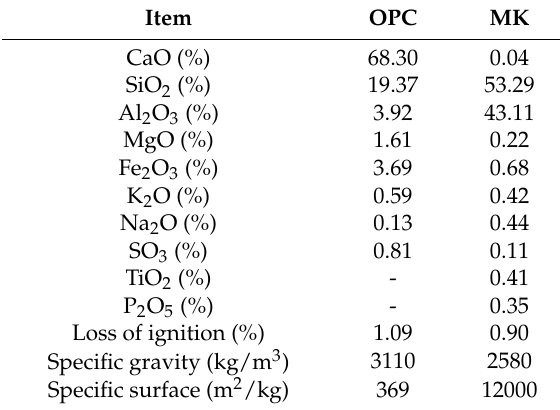
Table 1. Chemical analysis and physical properties of ordinary Portland cement (OPC) and metakaolin (MK).